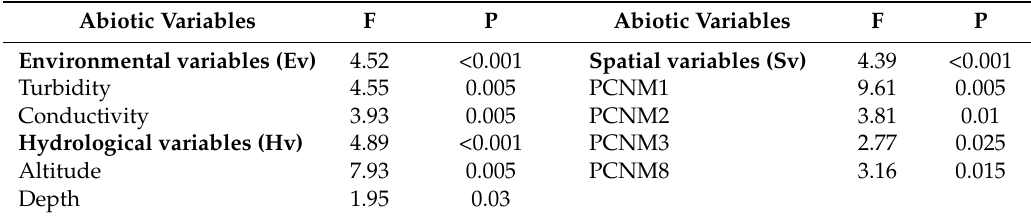
Table 4. Results of forward selection of environmental (Ev), hydrological (Hv), and spatial (Sv) variables for species composition in upstream Lijiang River.